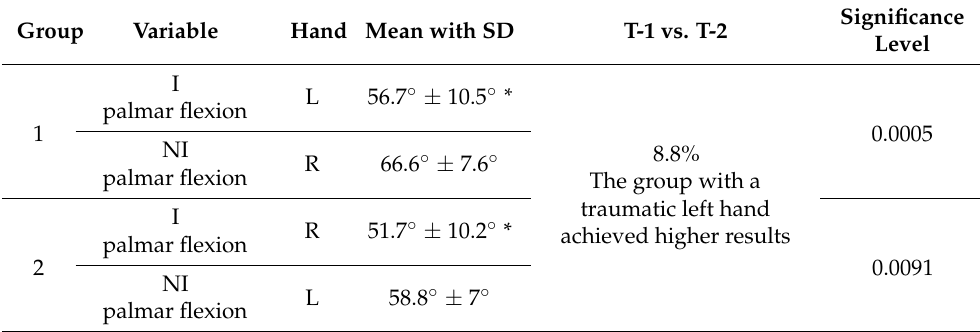
Table 2. Comparison of results for palmar flexion.